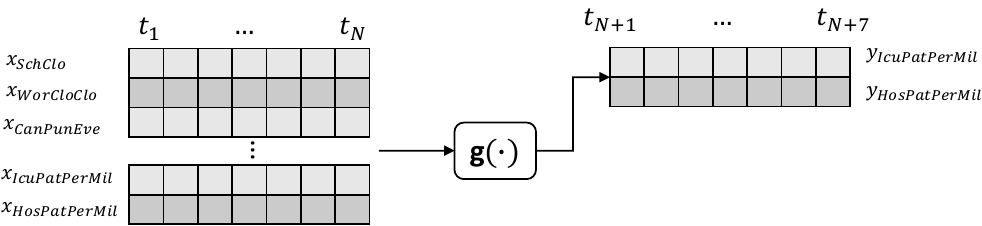
Figure 2. Daily hospitalization and intensive care unit submissions due to the COVID-19